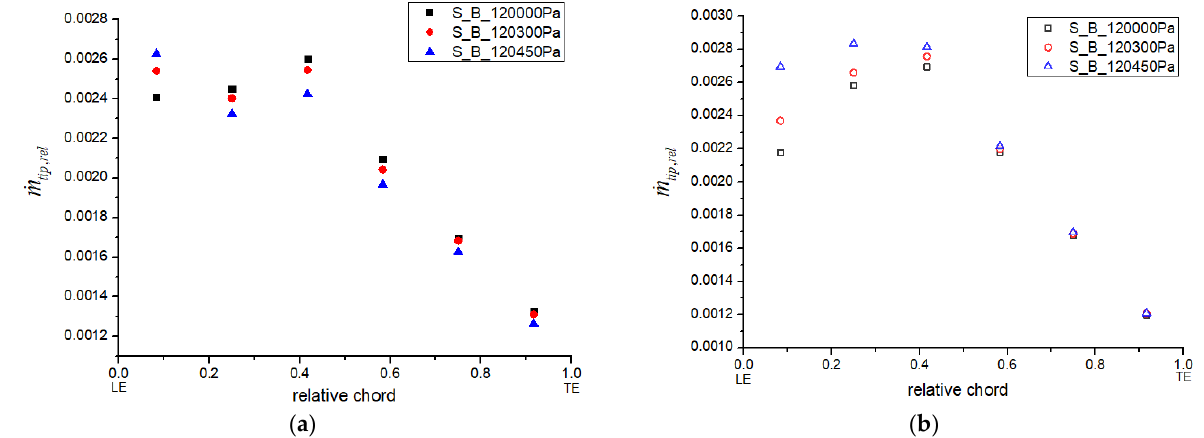
Figure 12. Relative leakage flow distribution with the S_B model at 6000 rpm. ( a ) First-stage rotor, R1, and ( b ) second-stage rotor, R2.